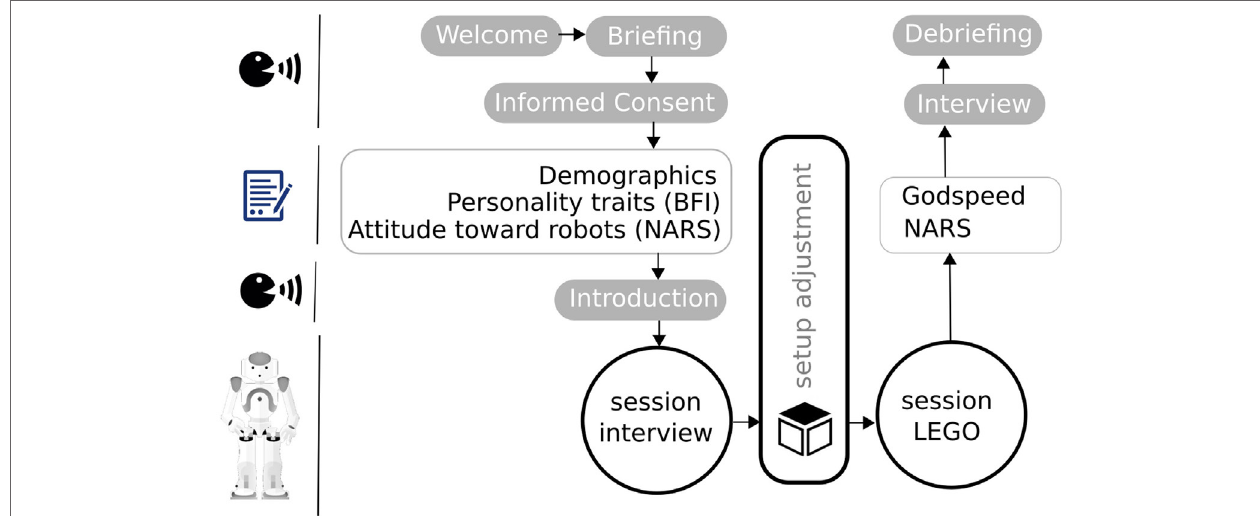
FigUre 3 | study procedure